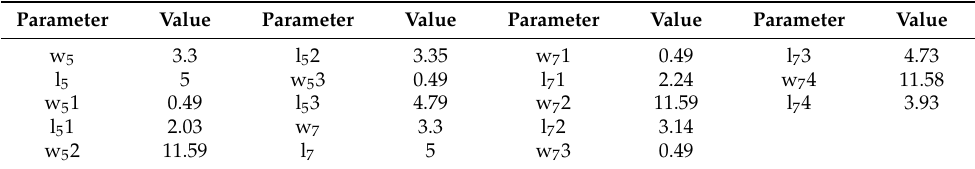
Table 3. Design parameters of fifth- and seventh-order Chebyshev low-pass filters with a cutoff frequency of 4 GHz (unit: